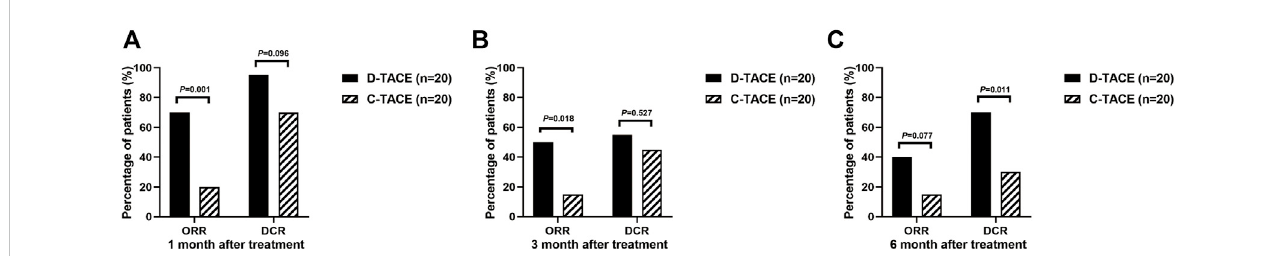
FIGURE 2 ORR and DCR evaluating by modi fi ed Response Evaluation Criteria in Solid Tumors (mRECIST) in D-TACE group and C-TACE group. The comparison of ORR and DCR at 1 month (A) , 3 months (B) , 6 months (C) after therapy between D-TACE group and C-TACE group. CR = complete response, PR = partial